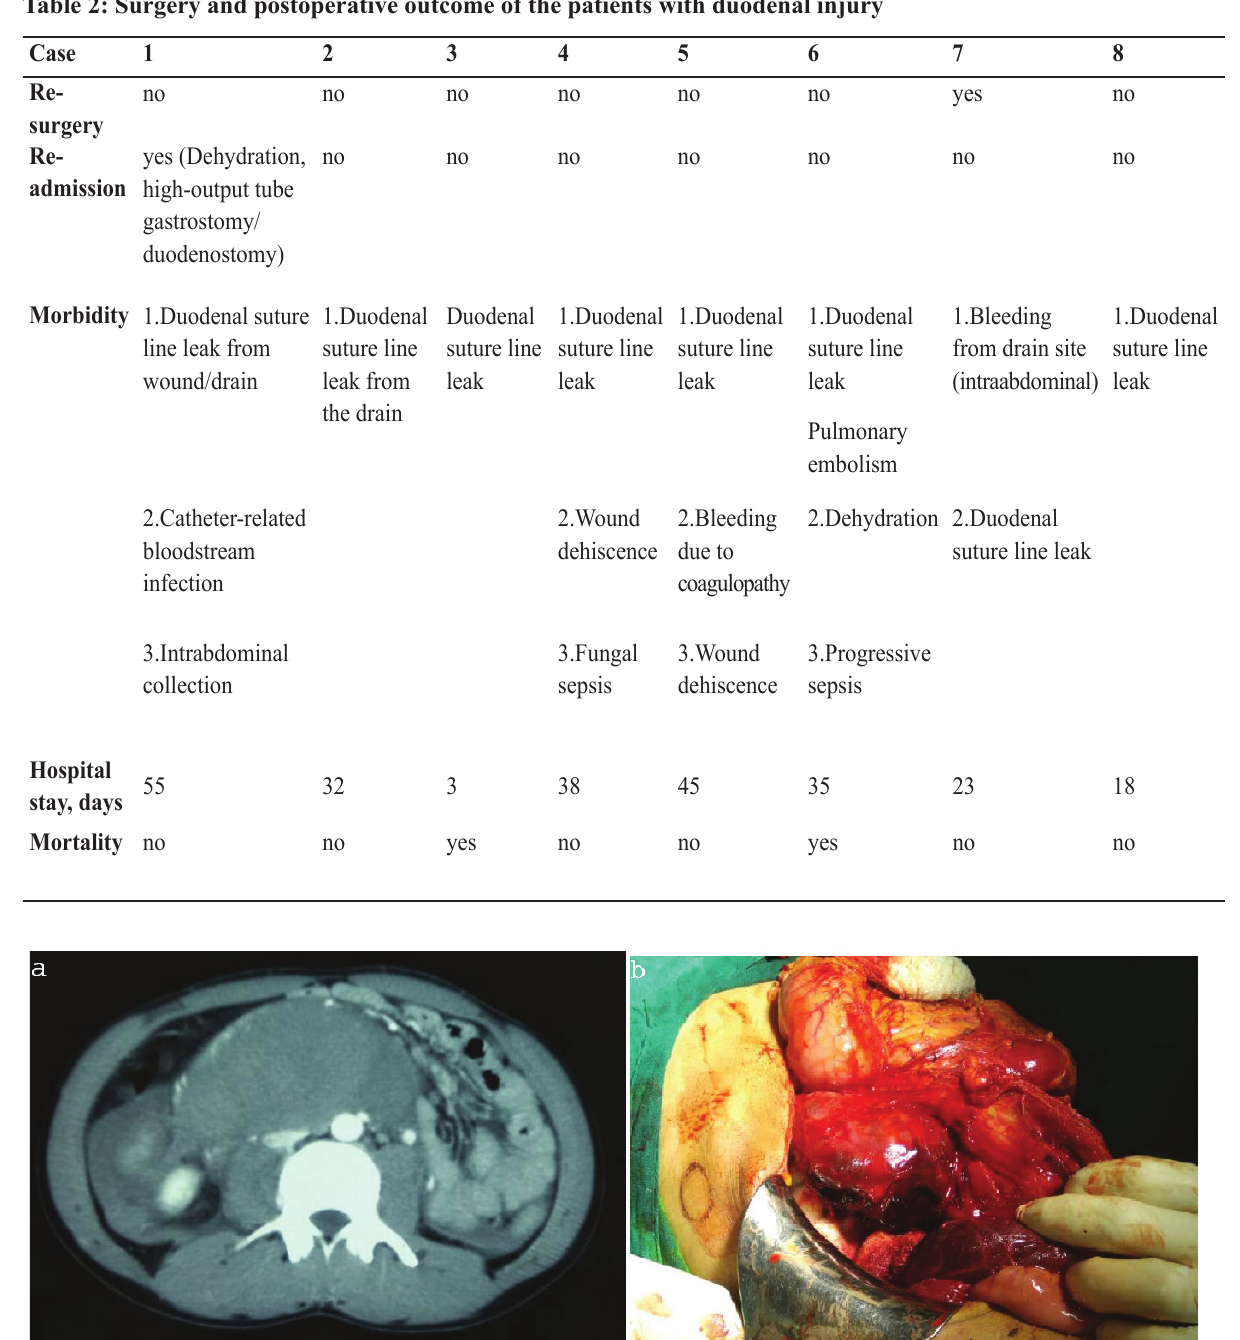
Figure 3: Contrast CT abdomen (a) showing a large (12x10 cm) intramural duodenal hematoma, compressing the duodenal lumen at the periphery. Intraoperative photograph (b) undergoing evacuation of the